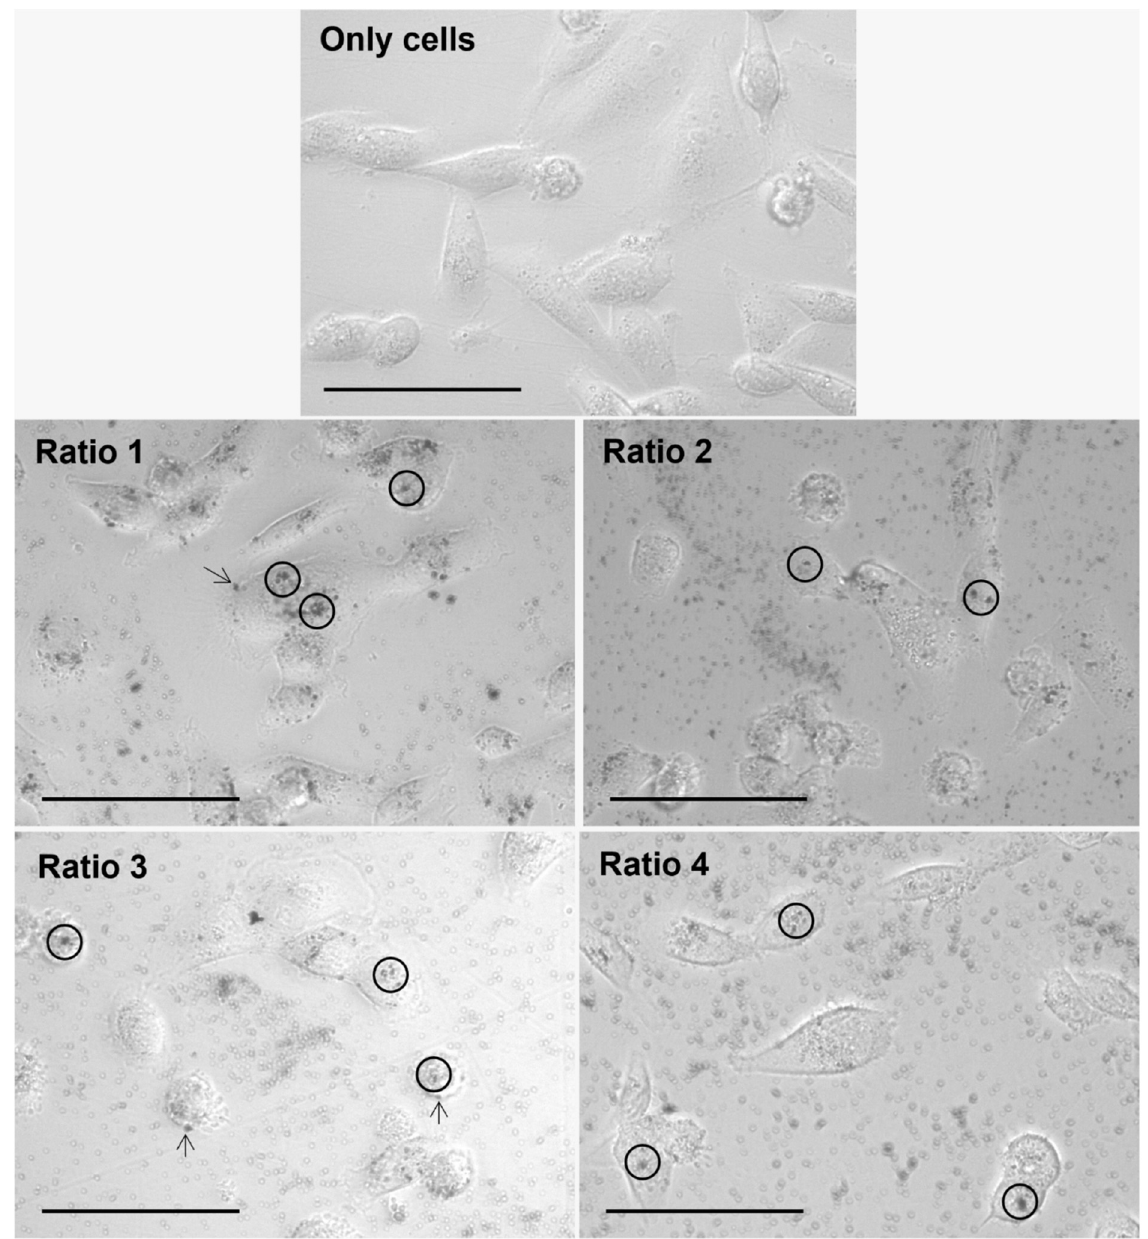
Figure 9. Representative images of MDA-MB-231 cells alone (Only cells) and after 4 h of incubation with different types of AuNPs (Ratio 1, Ratio 2, Ratio 3 and Ratio 4 AuNPs) at 40 × magnification. AuNPs appear as darker structures either inside the cell (circle) or at the cell surface (arrow). Scale bar = 75 µm.